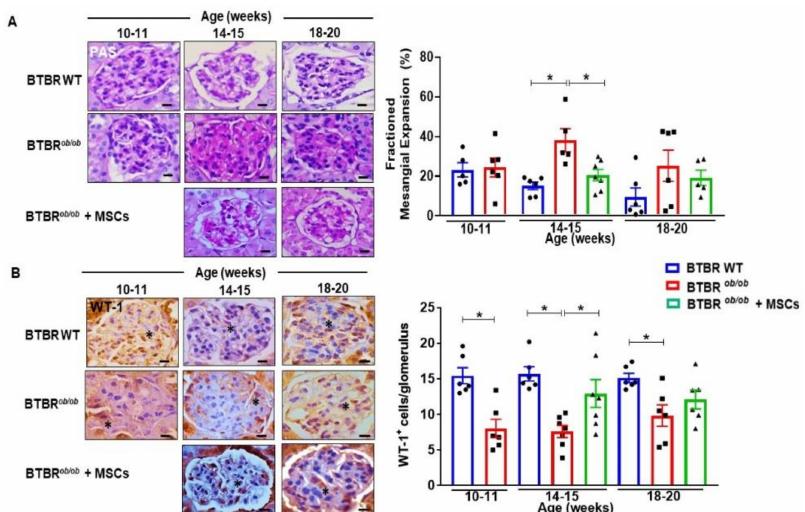
Figure 8. MSCs preserve BTBR ob/ob kidneys from mesangial expansion and podocyte loss. ( A ) DKD promoted increased matrix deposition in mesangial compartment of BTBR ob/ob mice at 14–15 weeks of age (* p < 0.05). MSC treatment curtailed mesangial expansion when 14–15 week-old MSC- treated BTBR ob/ob mice were compared to 14–15 week-old BTBR ob/ob mice (* p < 0.05). ( B ) Number of podocytes per glomerulus, verified by the immunohistochemistry staining for WT-1 protein, decreased as DKD progressed in BTBR ob/ob mice when compared to BTBR WT ( p < 0.05). MSC treatment showed a protective effect as podocyte maintenance leading to a higher number of WT-1 + cells in 14–15 week old MSC-treated BTBR ob/ob mice in comparison to 14–15 week old BTBR ob/ob mice (* p < 0.05). BTBR WT was not statistically different at 18–20 weeks. (*) indicates WT1 + cell. Scale bars represent 10 µ m in (A and B). Error bars represent mean ± SEM. For periodic acid-Schiff (PAS) and WT-1 staining: n = 5–7